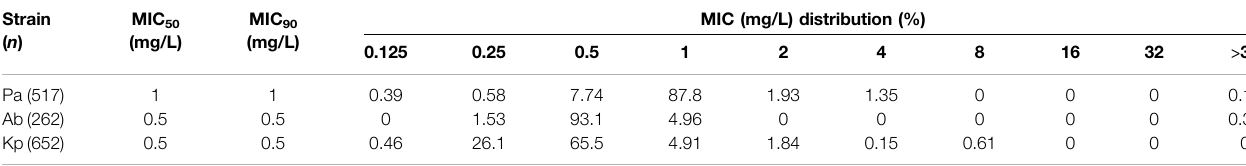
TABLE 1 | Polymyxin B MIC distributions for P. aeruginosa , A. baumannii and K. pneumoniae . a